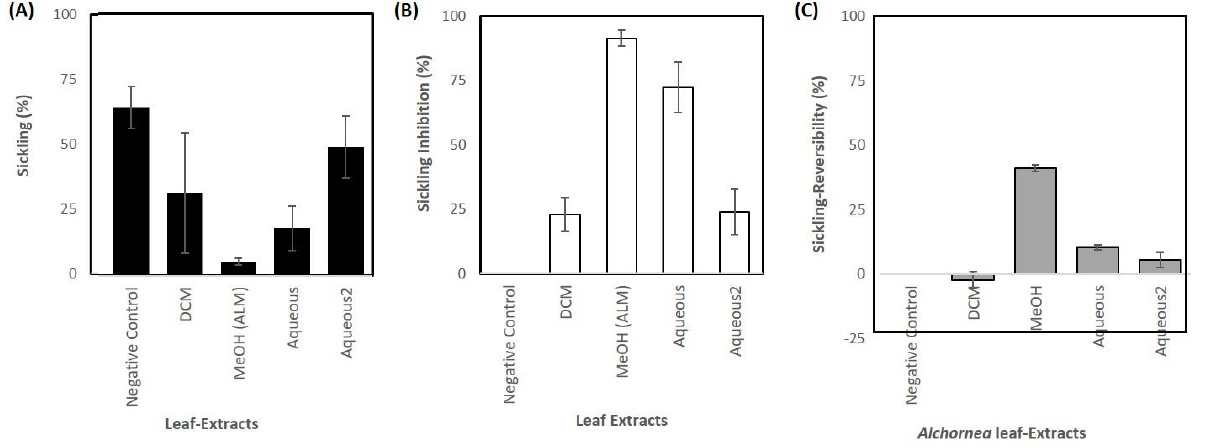
Figure 2. The effect of Alchornea spp. leaf extracts (1 mg/mL) on percentage sickling on incubation with erythrocytes in Na 2 S 2 O 5 -induced hypoxic conditions. ( A ) Percentage sickling, ( B ) percentage sickling inhibition, and ( C ) percentage reversion of sickling. The data represent the average of three similar results from the repeat experiments. The negative controls are the sickled erythrocytes in Na 2 S 2 O 5 -induced hypoxic conditions that were not treated with Alchornea spp. leaf extracts. DCM = dichloromethane extract. ALM = Alchornea methanol extract (75 % methanol: 25 % H 2 O).